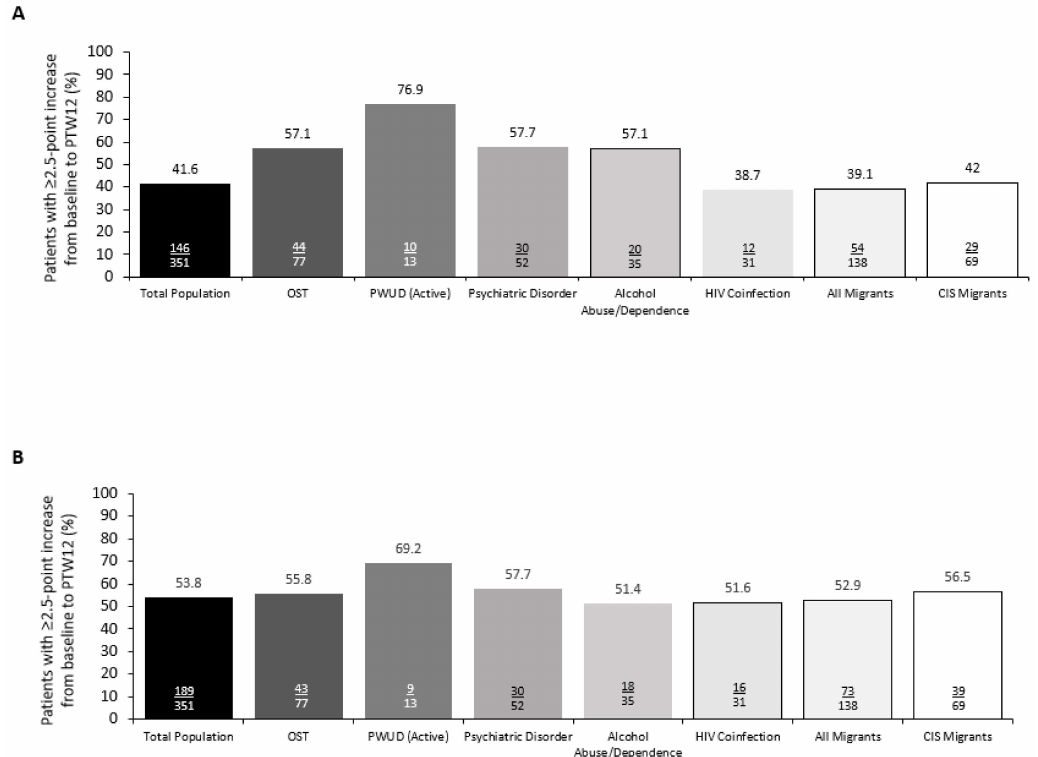
Figure 4. Percentage of patients with a clinically relevant improvement ( ≥ 2.5-point increase from baseline to PTW12) in ( A ) SF-36 physical component summary score and ( B ) SF-36 mental com- ponent summary score, according to key comorbidities and migrant status. CIS, Commonwealth of Independent States (Armenia, Azerbaijan, Belarus, Kazakhstan, Kyrgyzstan, Moldova, Russia, Tajikistan, and Uzbekistan); HIV, human immunodeficiency virus; OST, opioid substitution therapy; PTW, post-treatment week; PWUD (active), people who actively use